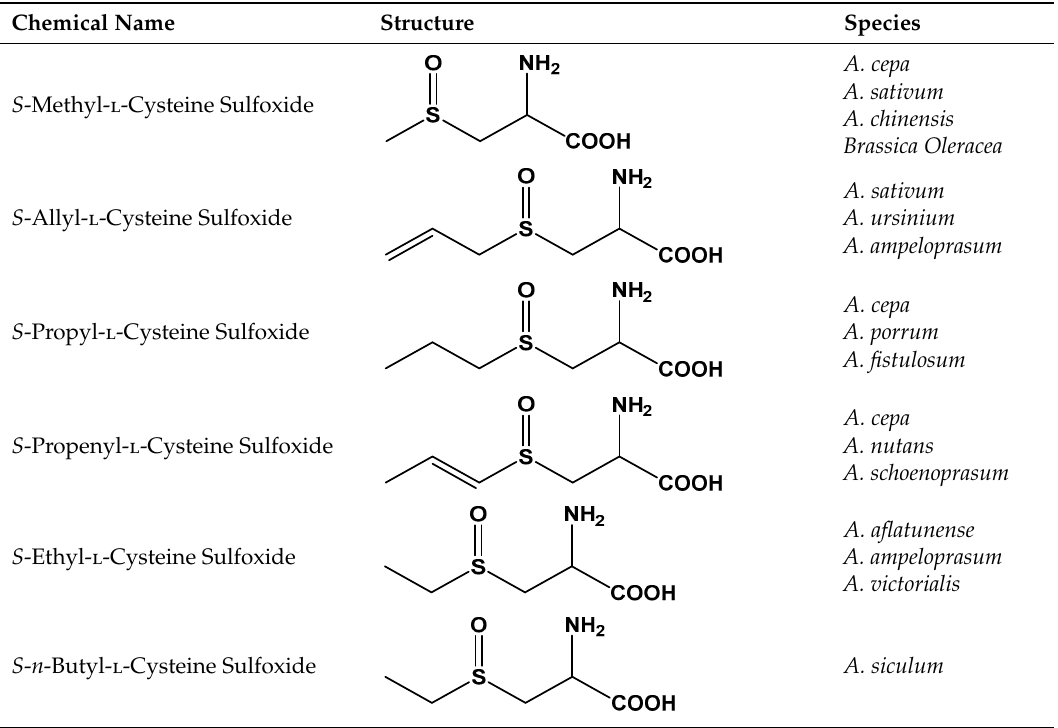
Table 1. Allium and brassica S -Alk(en)yl- L -cysteine sulfoxides (adapted from [2]).